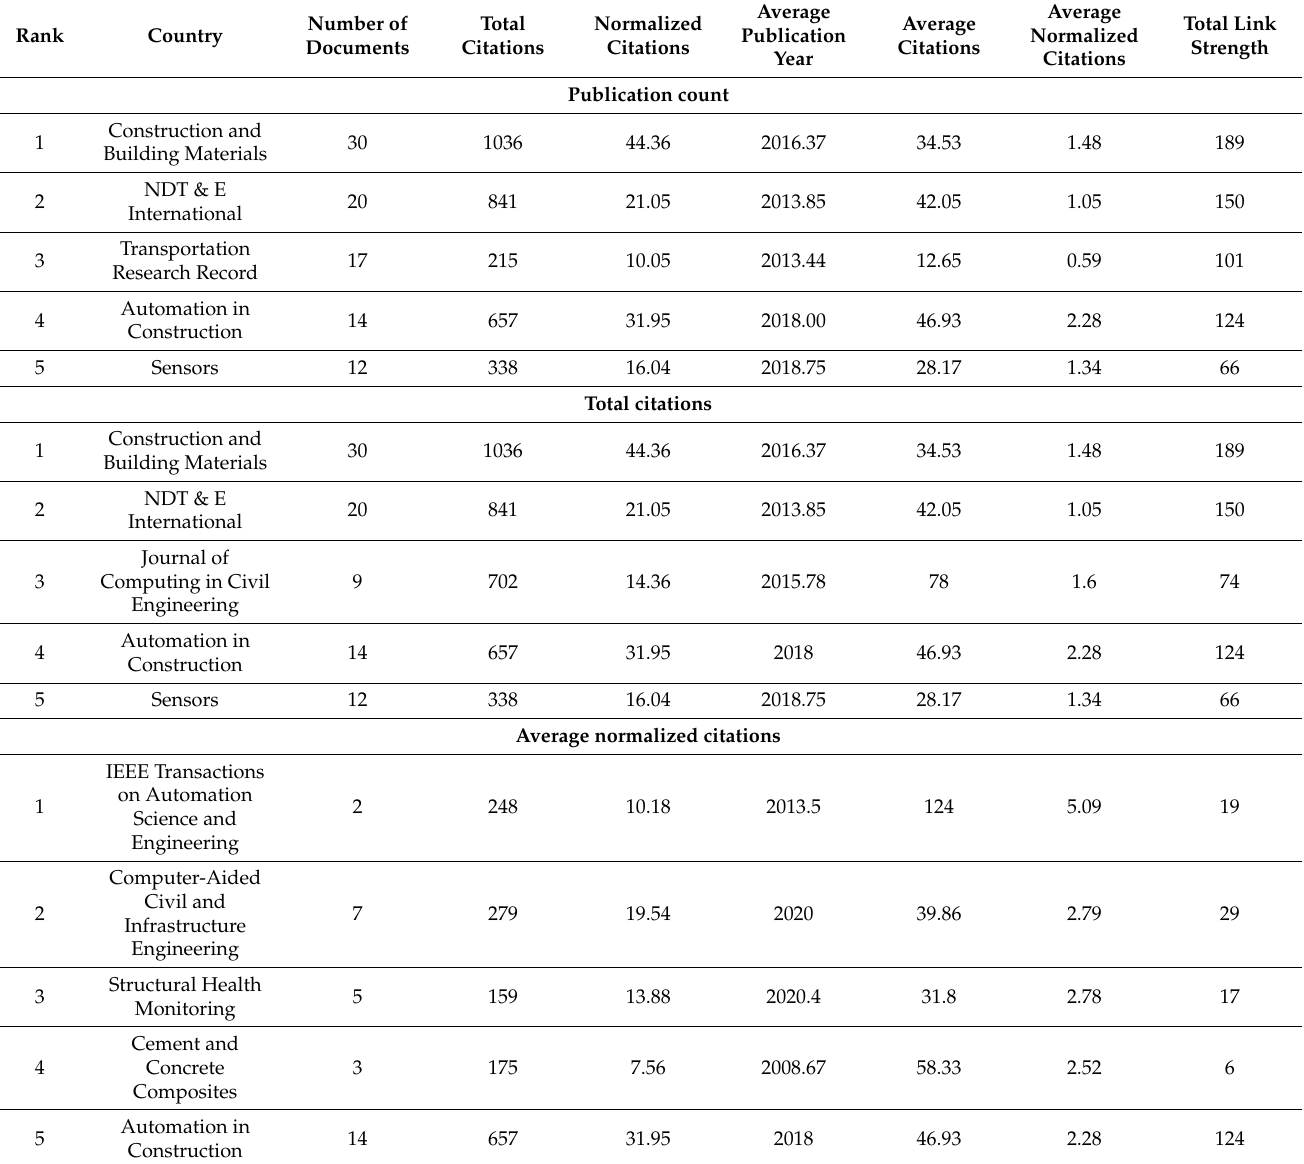
Table 3. Quantitative summary of active journals in the field of CBD_NDT with respect to publication count, total citations and average normalized